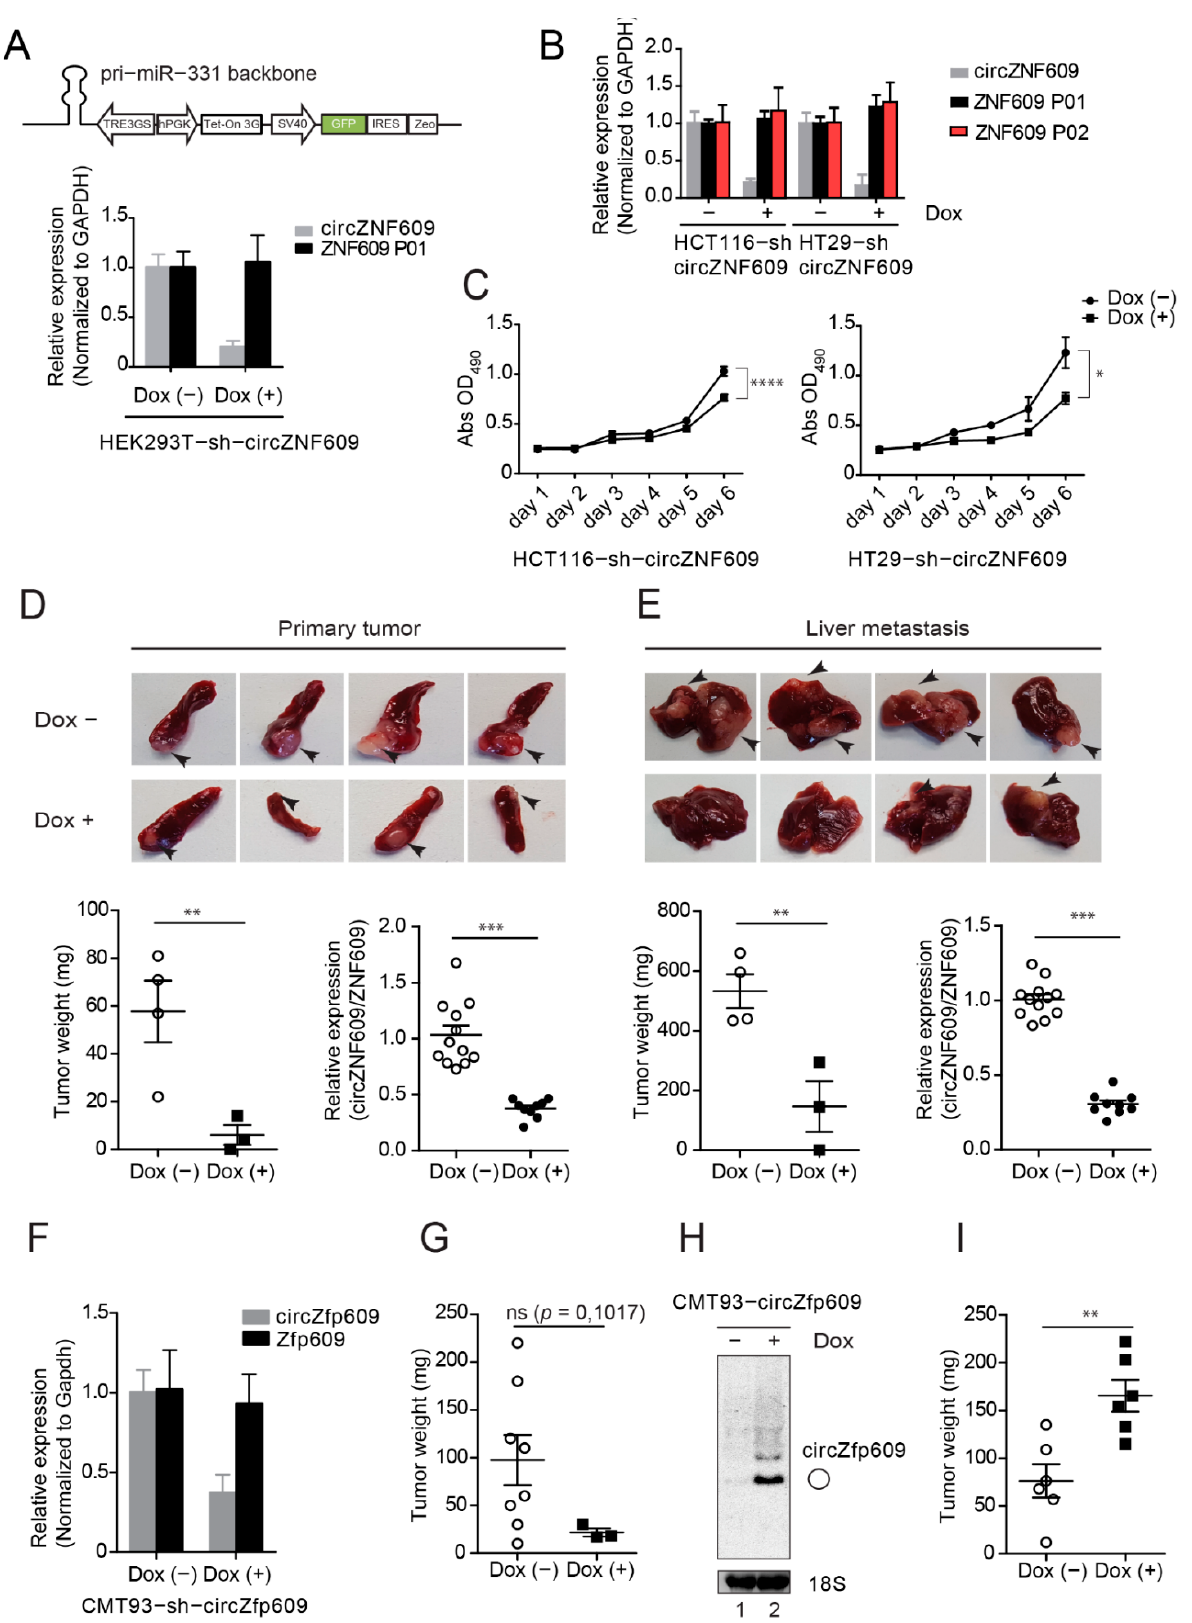
Figure 5. circZNF609 promotes colorectal cancer development. ( A ) shRNA design for knocking down of circZNF609 based on pri-miR-331 cassette driven by Poll-II promoter. shRNA targeting circZNF609 was designed by replacing miR-331 se- quence. Using this construct, circZNF609 is efficiently knocked down in HEK293T-sh-circZNF609 upon doxycycline in- duction. ( B ) Relative expression of circZNF609 and ZNF609 (using two different primer pairs P01 and P02) in HT29-sh-